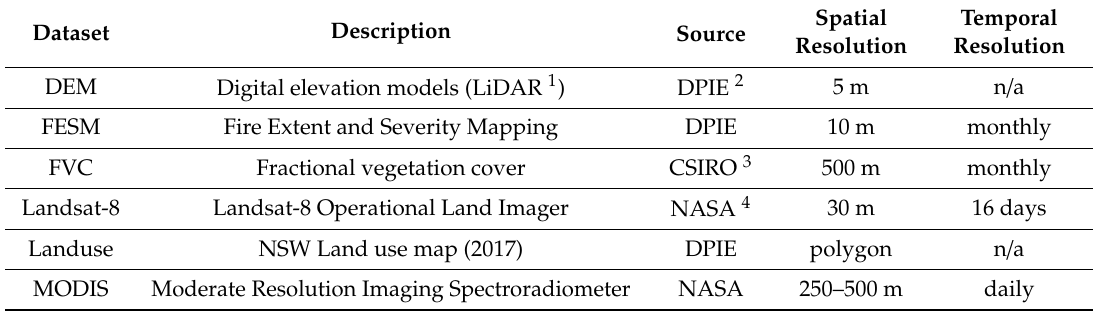
Table 1. Summary of the primary datasets used in this